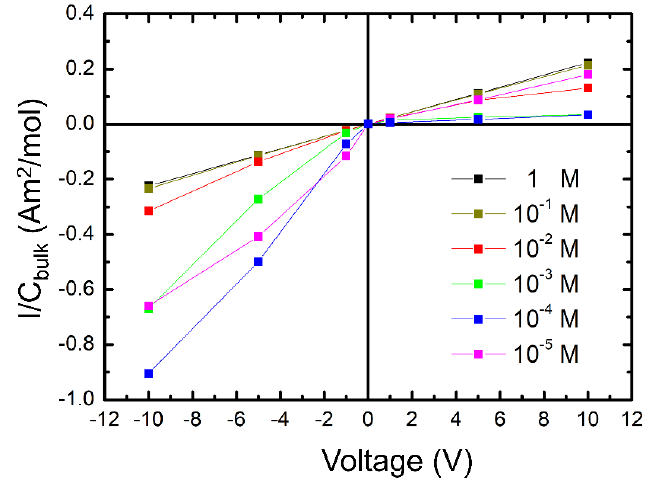
Figure 11. Current I normalized with respect to C Bulk as a function of the applied voltage V for different values of C Bulk : 1 M (black squares), 10 −1 M (dark yellow), 10 −2 M (red), 10 −3 M (green), 10 −4 M (blue), and 10 −5 M (magenta).